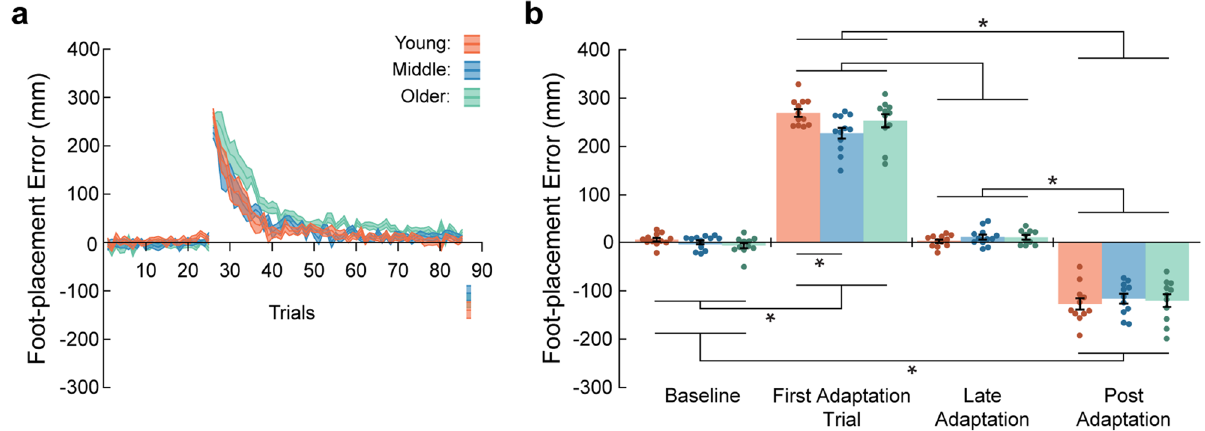
Figure 2. Aging and visuomotor adaptation. ( a ) Group mean ± SE foot-placement error across all trials for baseline, adaptation, and post-adaptation phases during the first testing session. ( b ) Group mean ± SE foot- placement error for the baseline phase (average of the last ten trials), first adaptation trial, late adaptation (average of the last ten trials), and post-adaptation trials for the first target during the first testing session. *Indicate that values are significantly different from each other ( p <